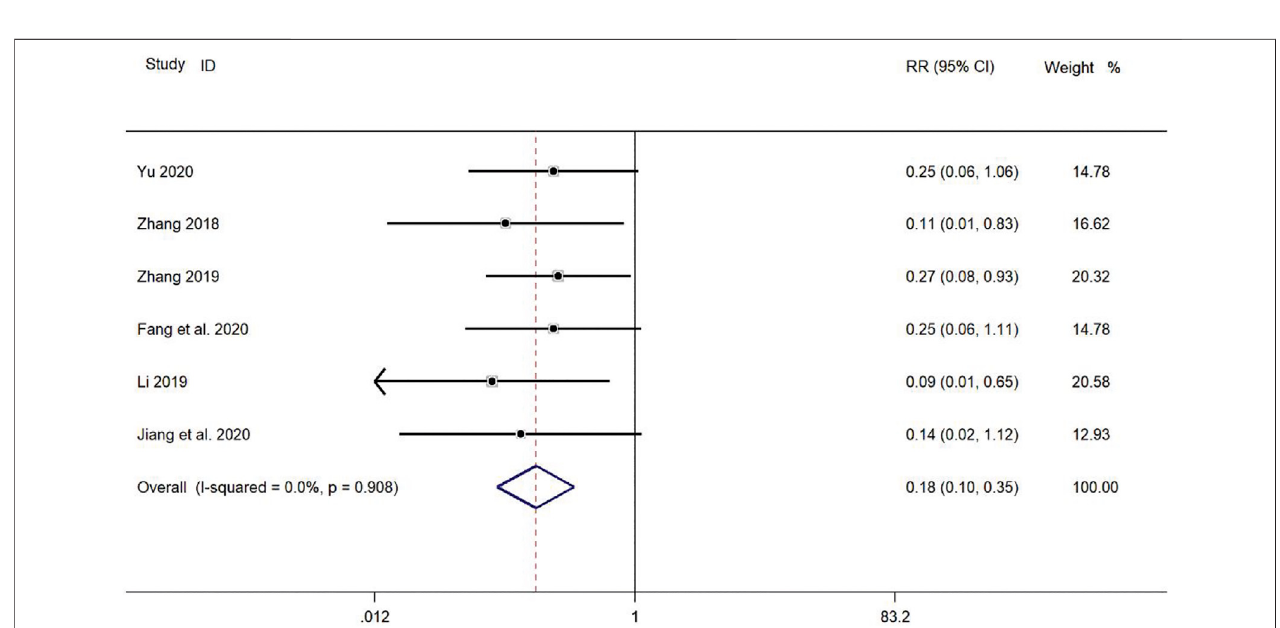
FIGURE 11 | Meta-analysis forest plot comparing the level of incidence of adverse reactions in the experimental and control group.